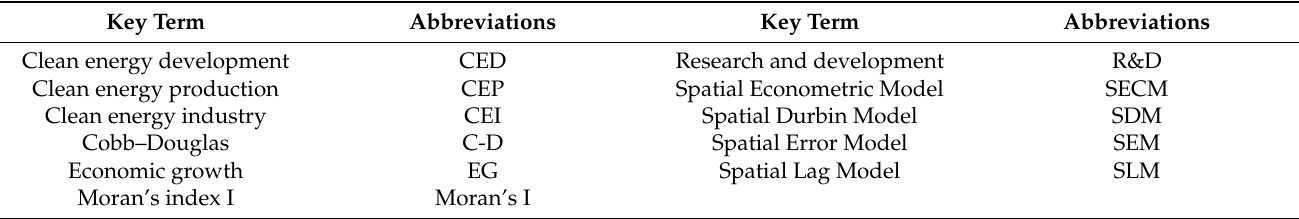
Table A1. The abbreviations of key